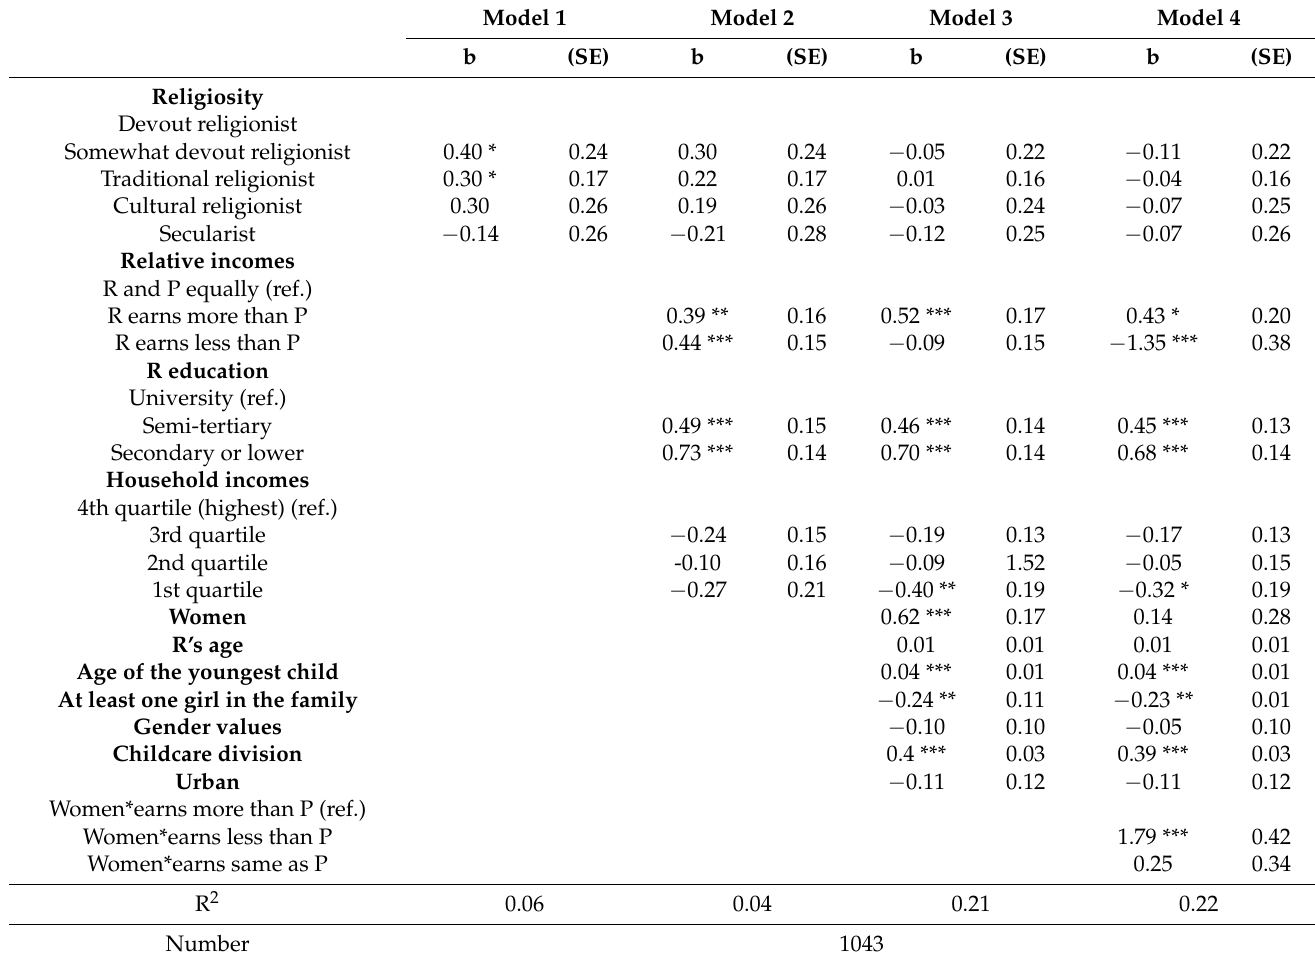
Table 3. Multivariate regression results for housework division (egalitarian–traditional), unstandardized b and standard